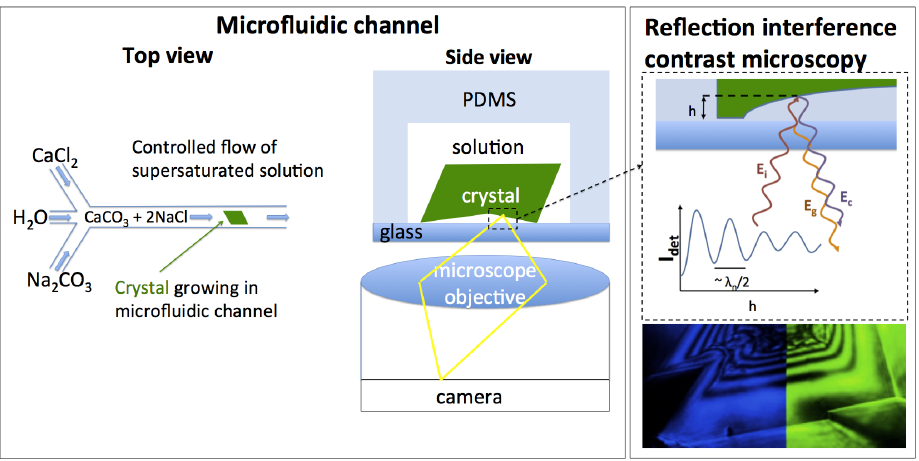
Figure 1. Controlled growth of calcite crystals in a microfluidic device studied by reflection interference contrast microscopy (RICM). ( Left ) Top view of the microfluidic channel showing how fluids are introduced and mixed to ensure stable supersaturation at the crystal surfaces. The microfluidic device rests on an inverted microscope to allow high resolution imaging of the crystal in situ during growth. The crystal grows on all surfaces, but the surface studied here is confined by the glass surface on which the crystal rests. ( Right ) Principle of RICM. The crystal is illuminated from the bottom, which is illustrated here by the electric field, E i , of the incident light. Due to the interference of the light reflected by the crystal-water interface, E c , with the light reflected by the glass-water interface, E g , the detected intensity, I det , depends on the distance, h , between the two interfaces and on the wavelength of the light, λ . Exemplary RICM images of a calcite crystal using a blue LED (left half) and a green LED (right half) are shown at the bottom. The fringes align at the outer part (rim) of the crystal, but differ for larger distances h towards the central part of the confined